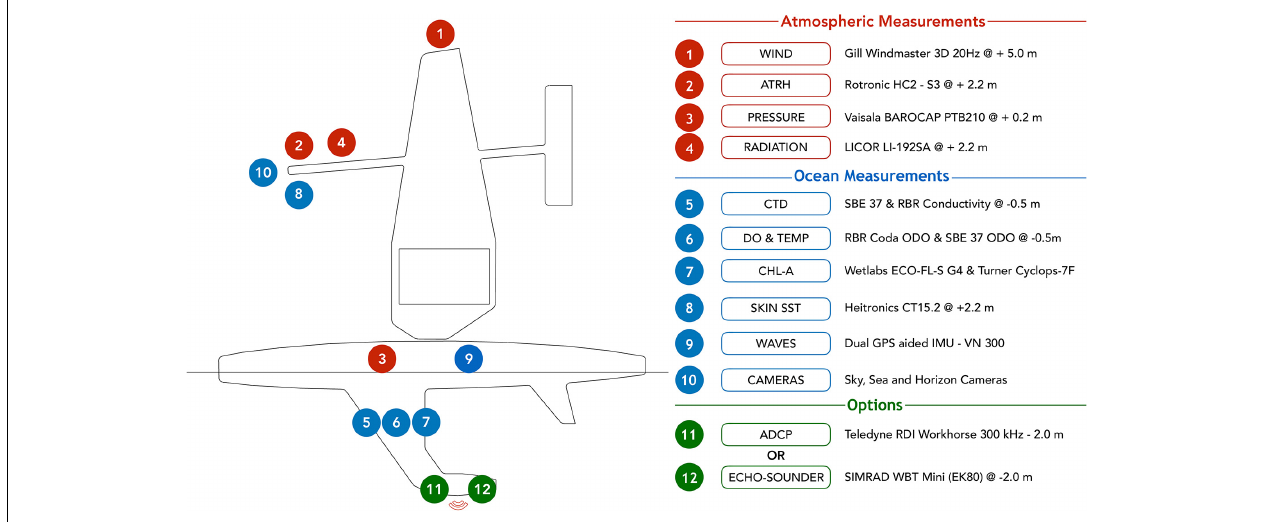
FIGURE 2 | Saildrone USV surface and subsurface core sensor suite. Additional application-specific sensors have routinely been added to the core suite to measure parameters such as atmospheric & dissolved p CO 2 , short and long wave solar radiation, passive acoustic recordings, and other specialized